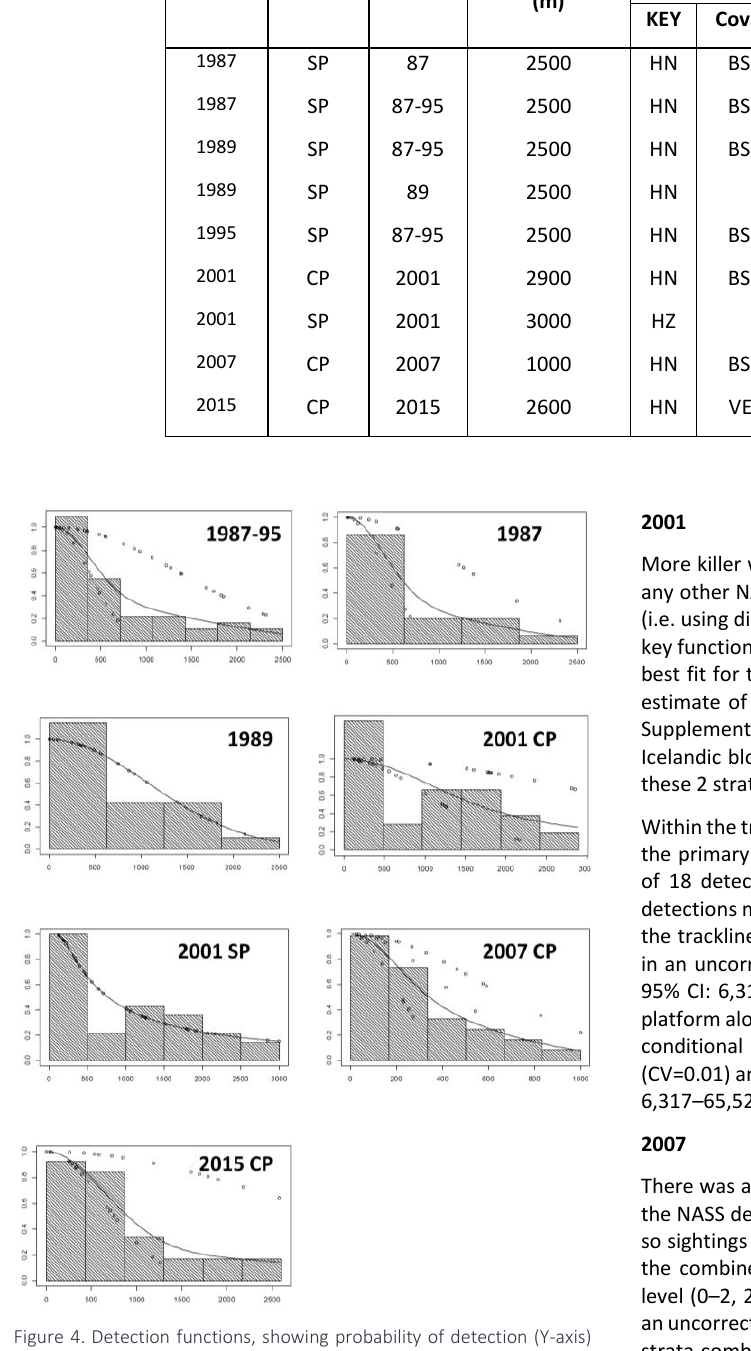
Figure 4. Detection functions, showing probability of detection (Y-axis) with perpendicular distance from trackline (m) (X-axis). Points are predicted values of observations based on distance and covariate levels (see Table 2). CP - combined platforms; SP - single platform.